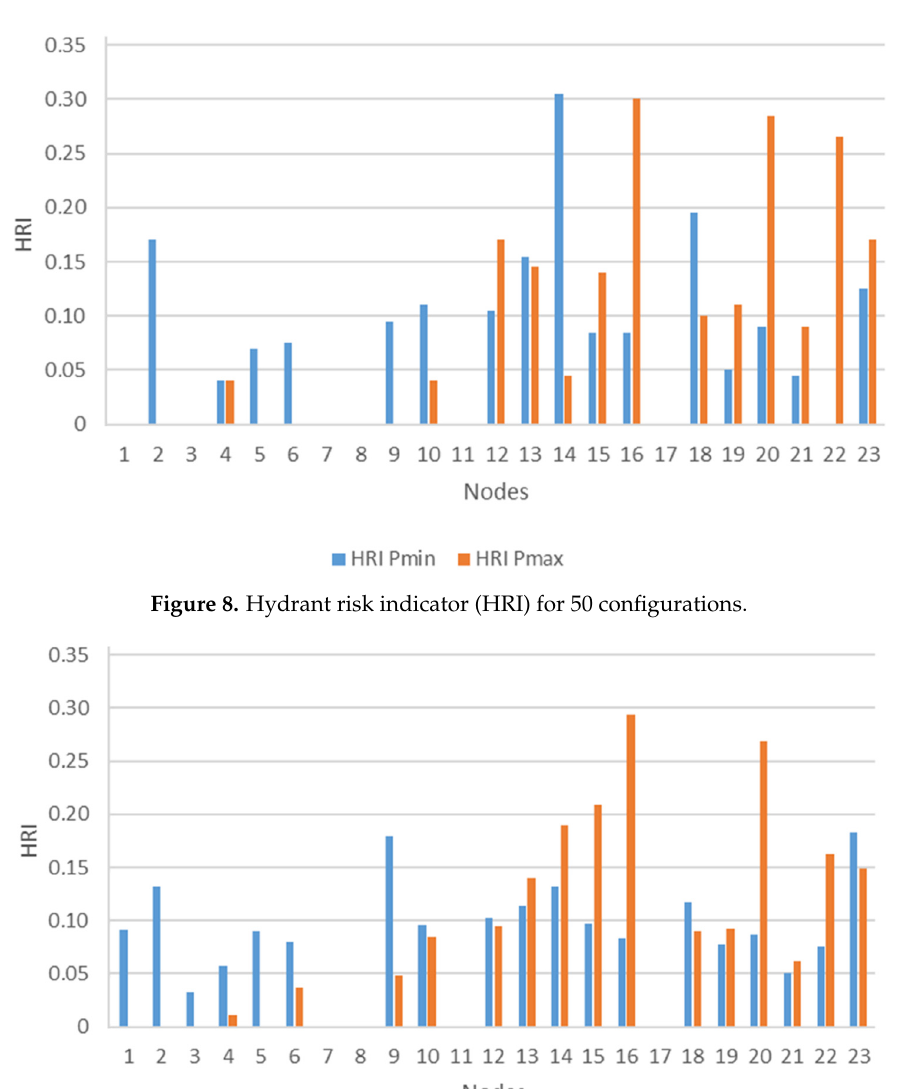
Figure 7. Pressure profile (Res-node 16) for 500 configurations, considering the simultaneous opening and closing of two different hydrants out of five.